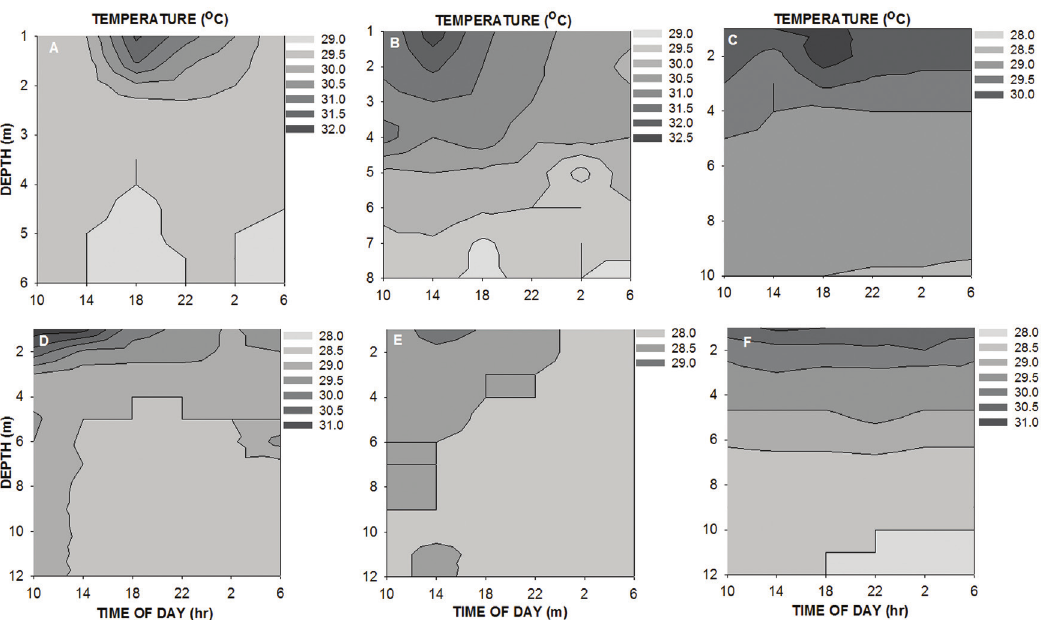
Figure 2. Daily variation in the vertical distribution of temperature in Lago Catalão during the months of: A) November; B) February; C) March; D)April; E) May and F)